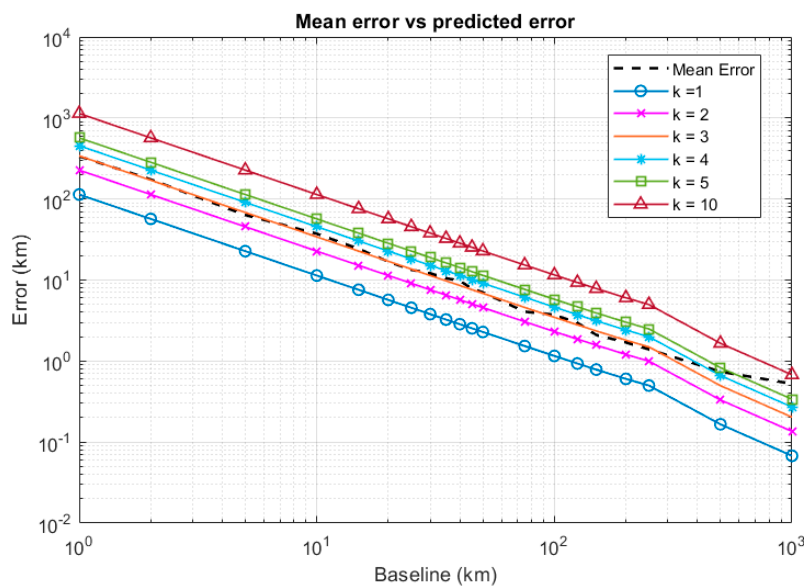
AVERAGE and k MIN versus baseline.